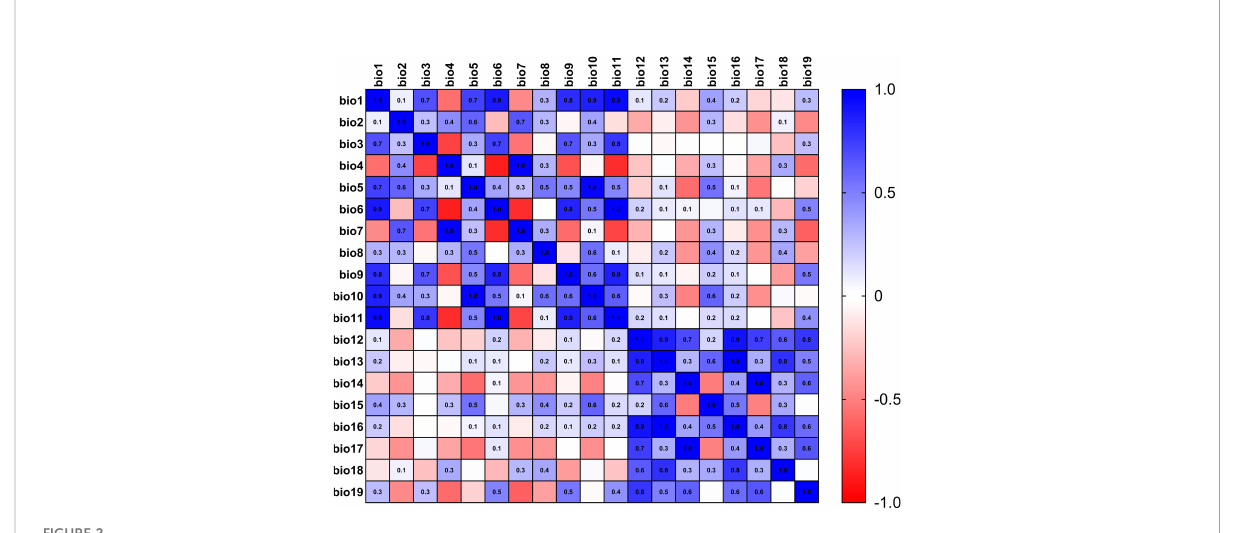
FIGURE 2 Heat map for correlation analysis of environmental factors in E. corollae.